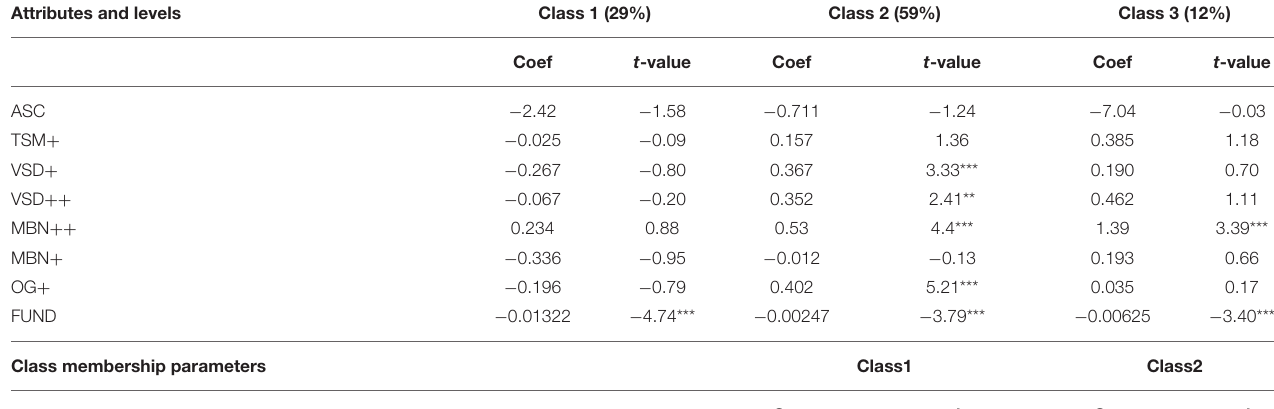
TABLE 5 | Results of heterogeneity preferences to establish an impact mitigation program. Attributes and